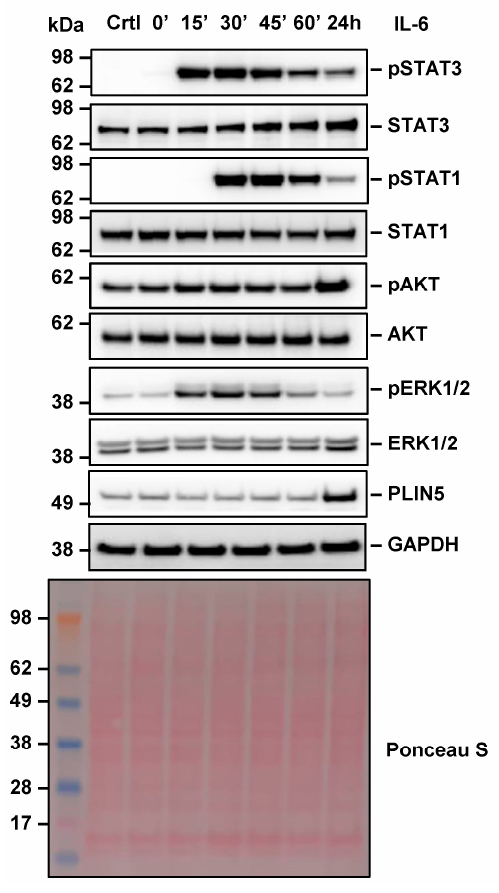
Figure 4. Effect of IL-6 stimulation on downstream signaling pathways in Hep3B cells. Hep3B cells were stimulated with IL-6 (10 ng/mL) for 0, 15, 30, 45, 60 min and 24 h and the activation of IL-6 downstream signaling components analyzed by Western blot analysis. GAPDH detection and Ponceau S staining served as controls to demonstrate equal protein loading.